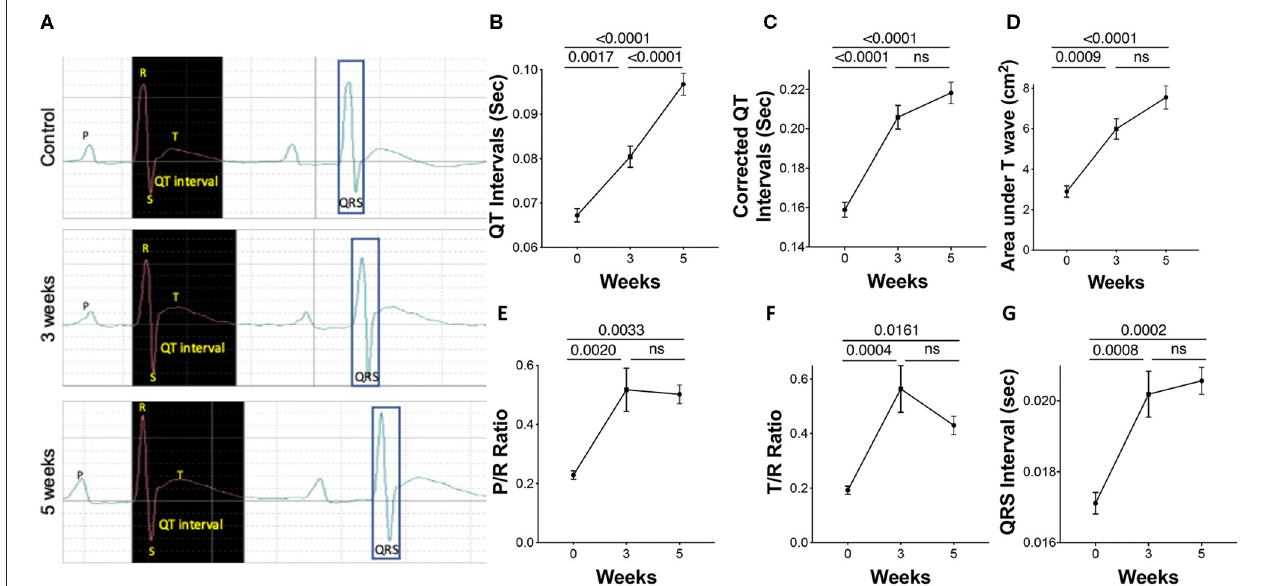
FIGURE 2 | Electrocardiographic parameters during PAH progression in rats. Pulmonary arterial hypertension was induced in rats as described in the Methods. A 2-channel electrocardiography (EKG) was utilized to record parameters. (A) Representative EKG tracings, showing (B) uncorrected QT intervals, (C) corrected QT intervals, (D) area under the T wave, (E) P/R ratio, (F) T/R ratio, and (G) QRS interval was also performed. N = 7–10